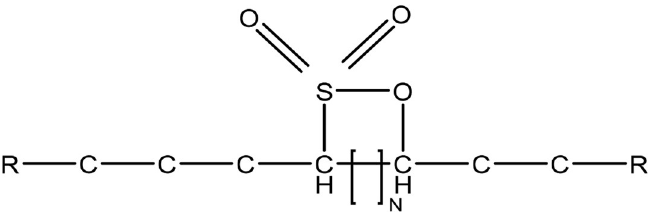
Figure 2. Chemical structure of Internal Olefin Sulfate (IOS).